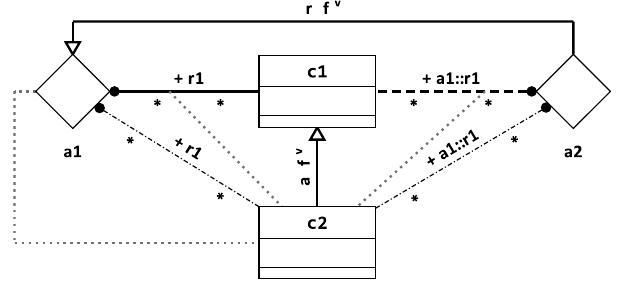
Fig. 17. Graphical representation of